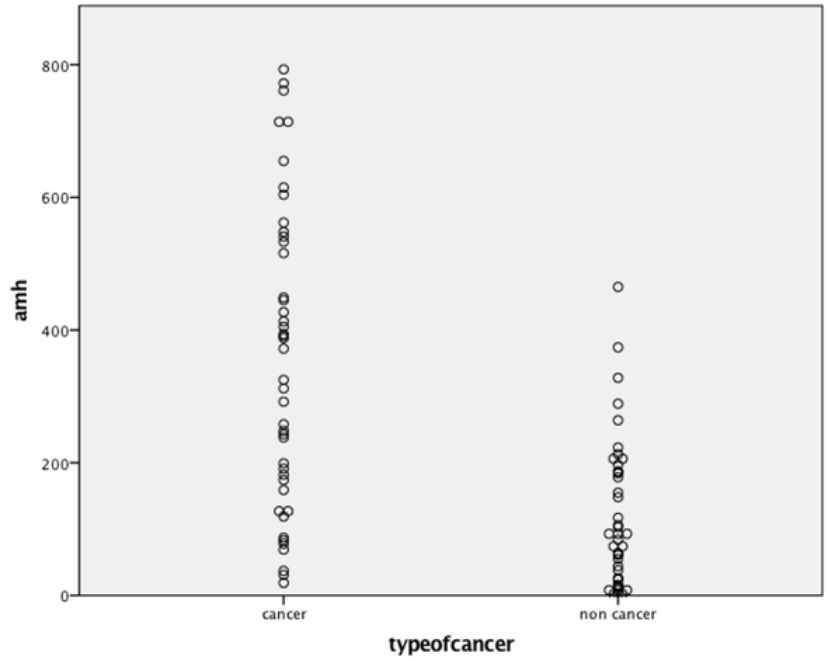
Figure 1. The dot plot of AMH levels distribution between cancer and non-cancer respondents.